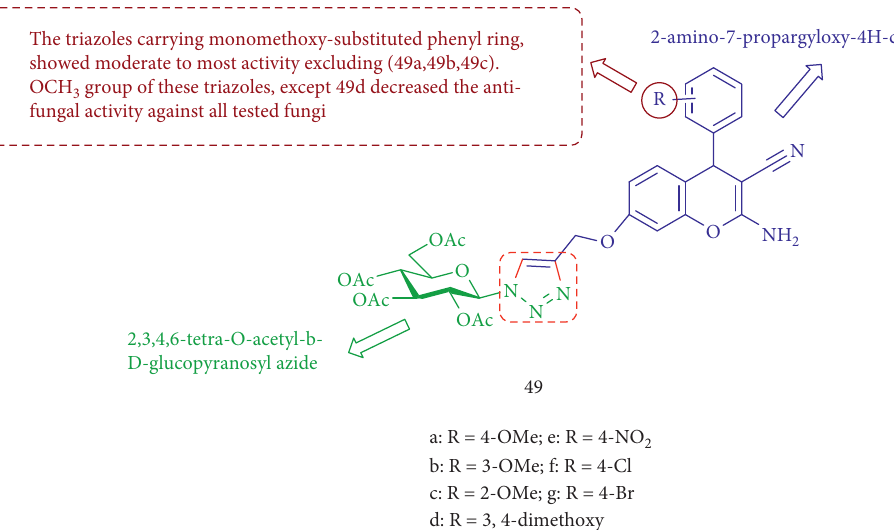
Cl group at para position of phenyl ring displayed resistance against all the NNNR examed fungal strains except A. niger